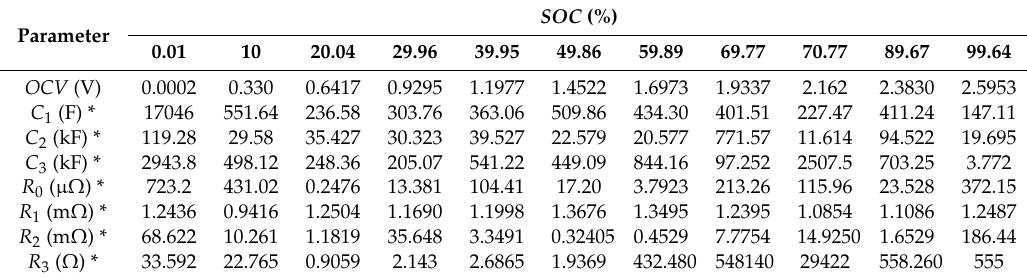
Table A8. Thevenin Model Parameters with i 2 Current Profile.